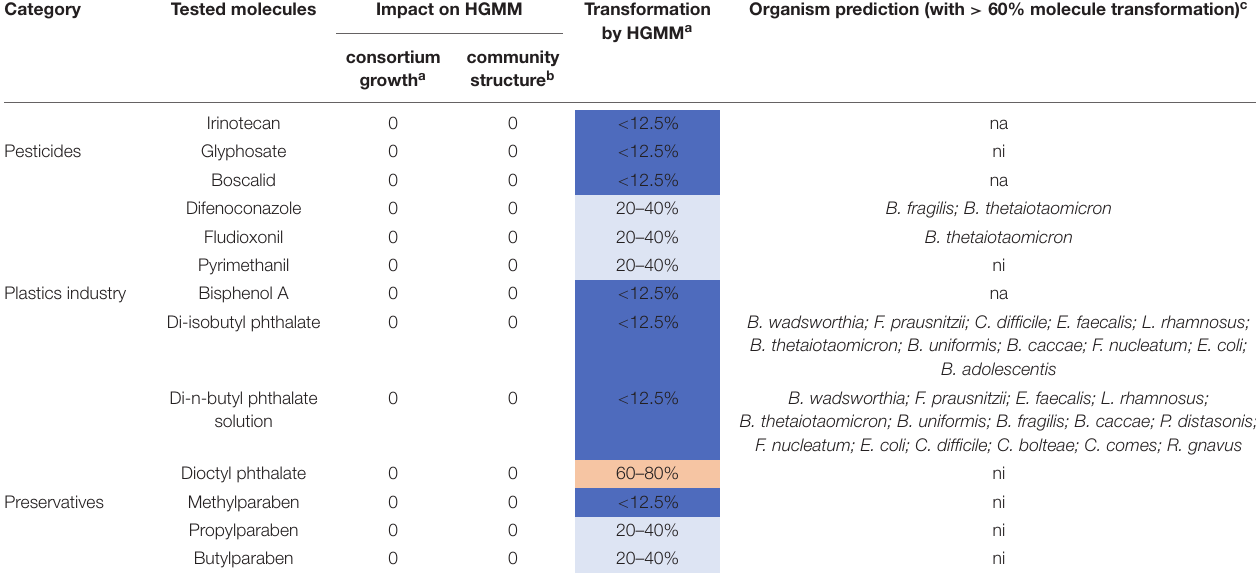
b Results from Figures 2 – 4 . c Results from Figure 7 and Table 2